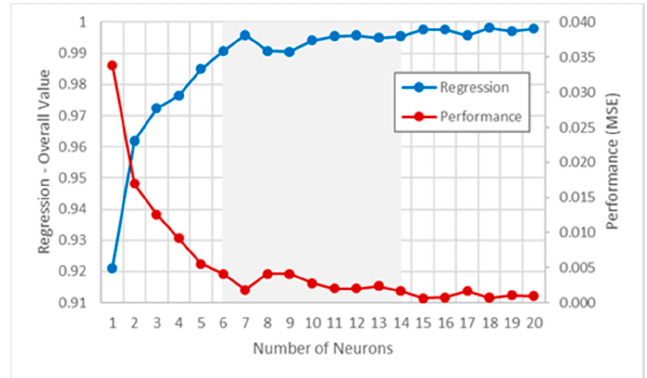
Figure 17. Neuron test—Broyden Fletcher Goldfarb Shanno quasi-Newton backpropagation (Trainbfgs)